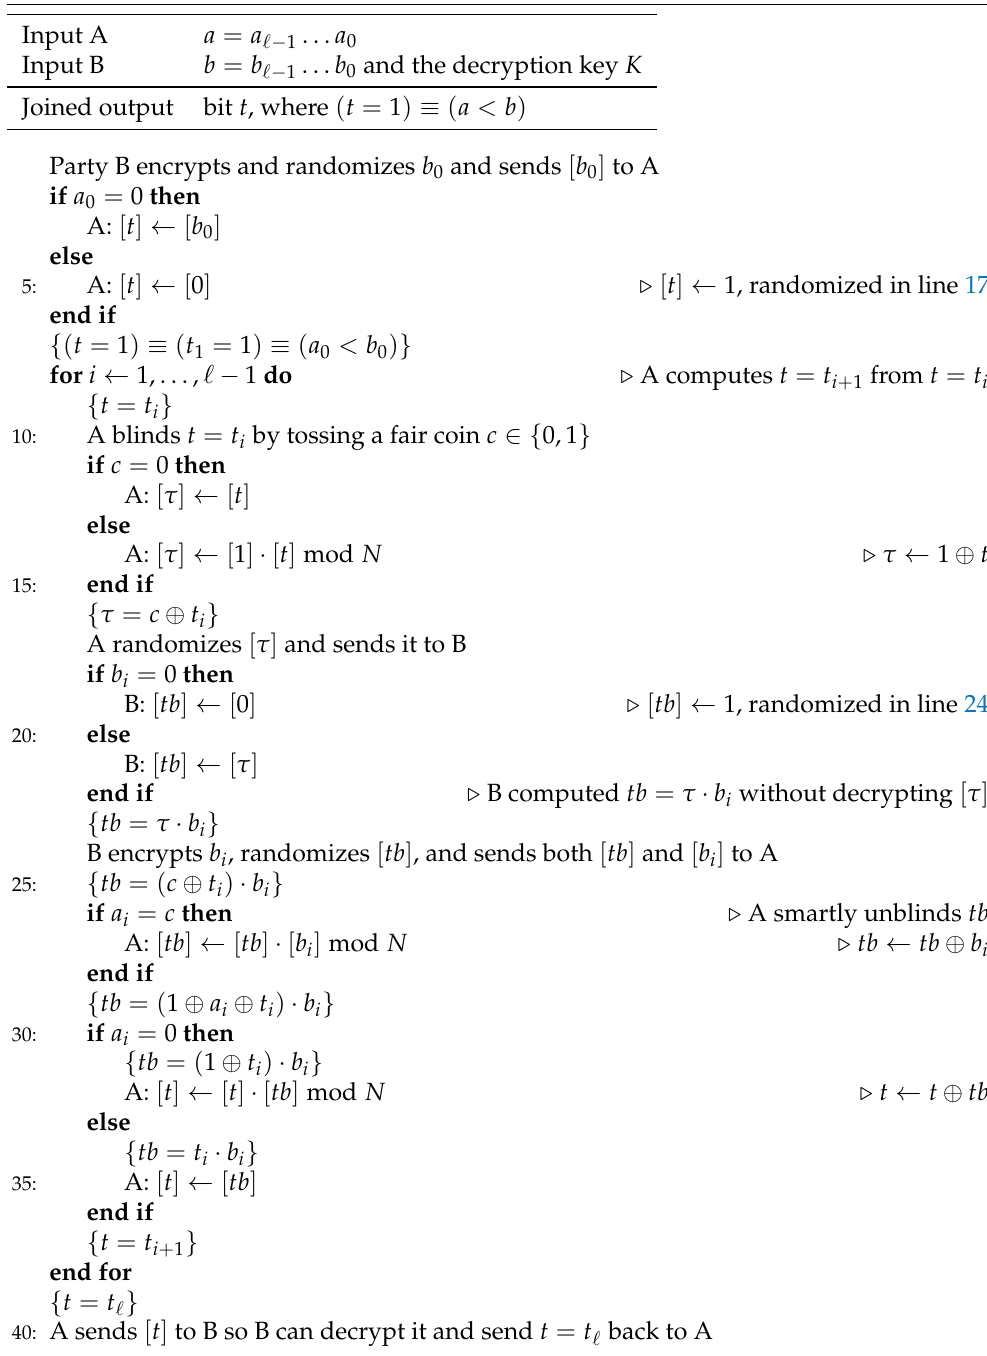
Algorithm 1 Lightweight secure integer comparison